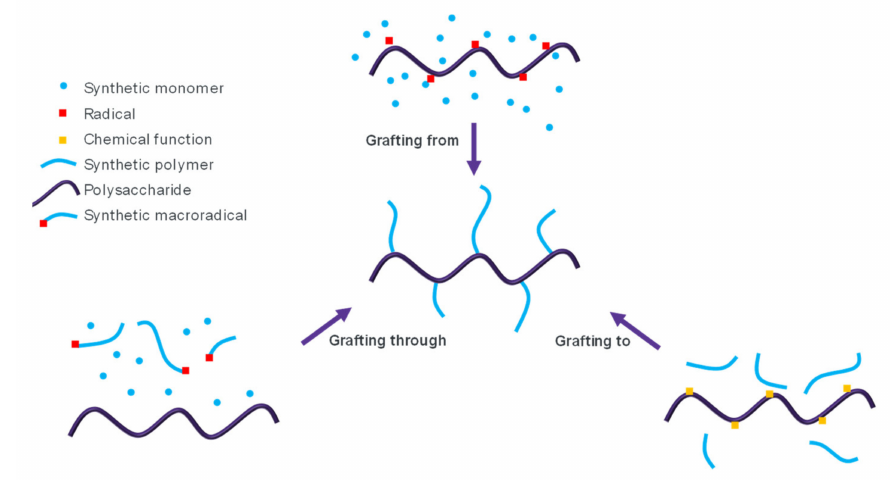
Figure 3. The three main mechanisms to prepare hybrid